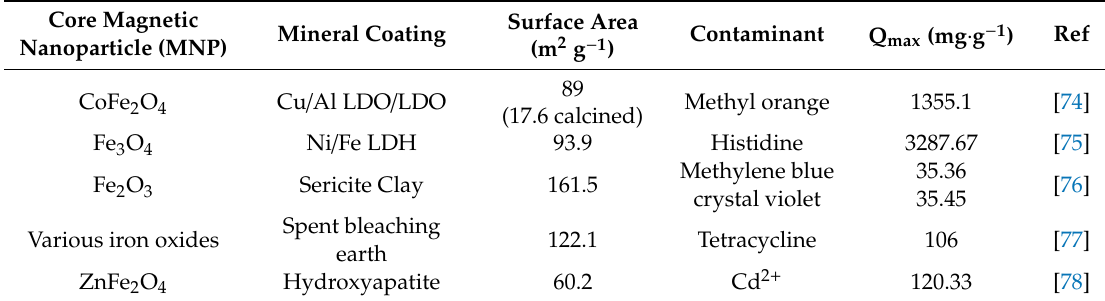
Table 3. Selected examples of adsorbent composites of clay-like materials and magnetic nanoparticles as